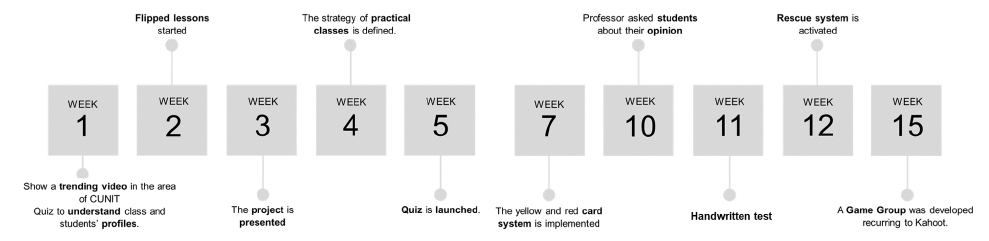
Figure 3. Week plan at Web